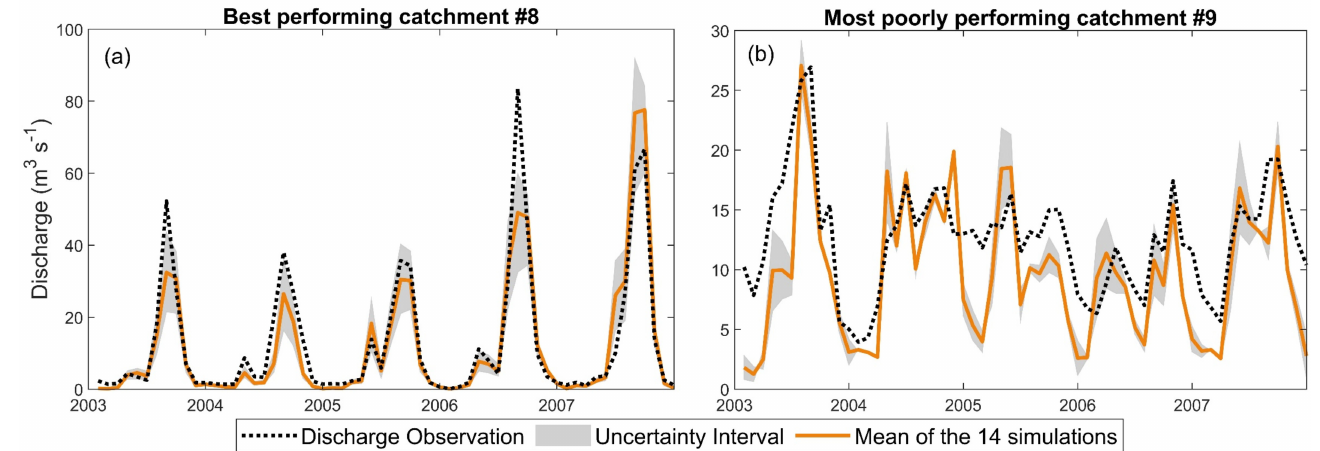
Figure 7. Prediction interval derived from the 14 regression models using the best parameter sets from stable parameter sets and uncertainty interval; ( a ) for best − performing catchment (#08) and mean of the 14 simulations, and ( b ) uncertainty interval for most poorly performing catchment (#09) and mean of the 14